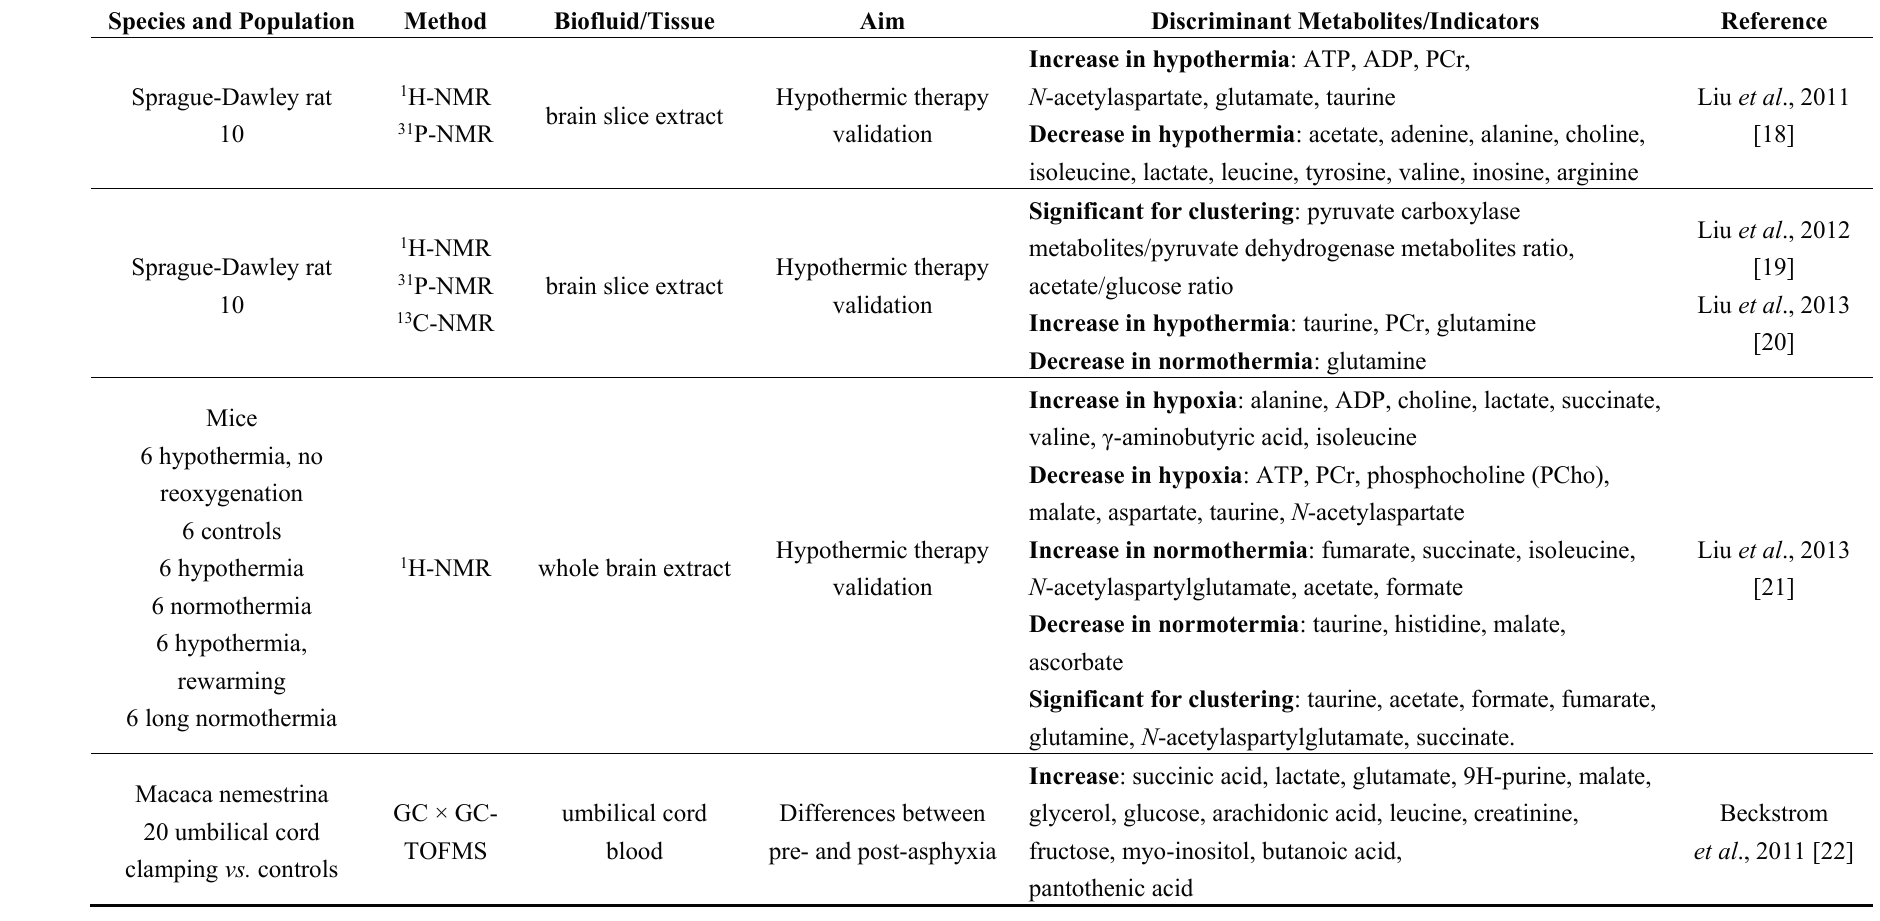
Table 1. Metabolomic analysis on animal